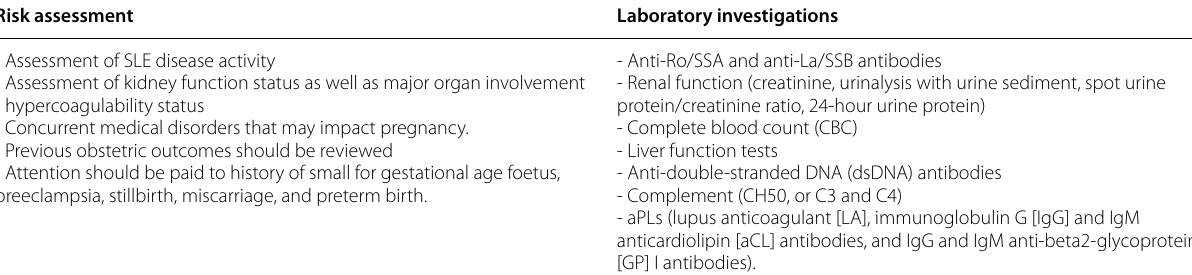
Table 2 stratifying individual patient risk: pre‑pregnancy counselling: assessment of the lupus nephritis risks and laboratory investigations